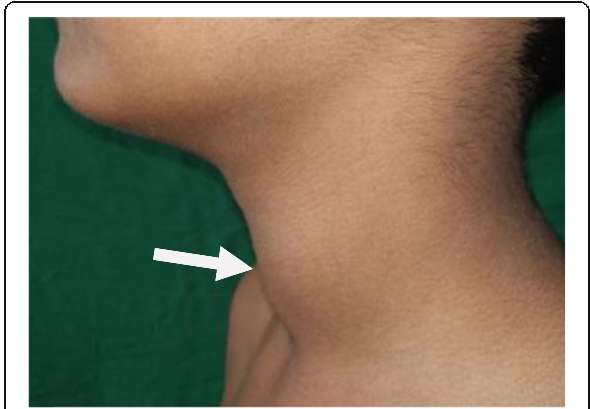
Fig. 1 Picture depicting swelling of neck over left side (white arrow)